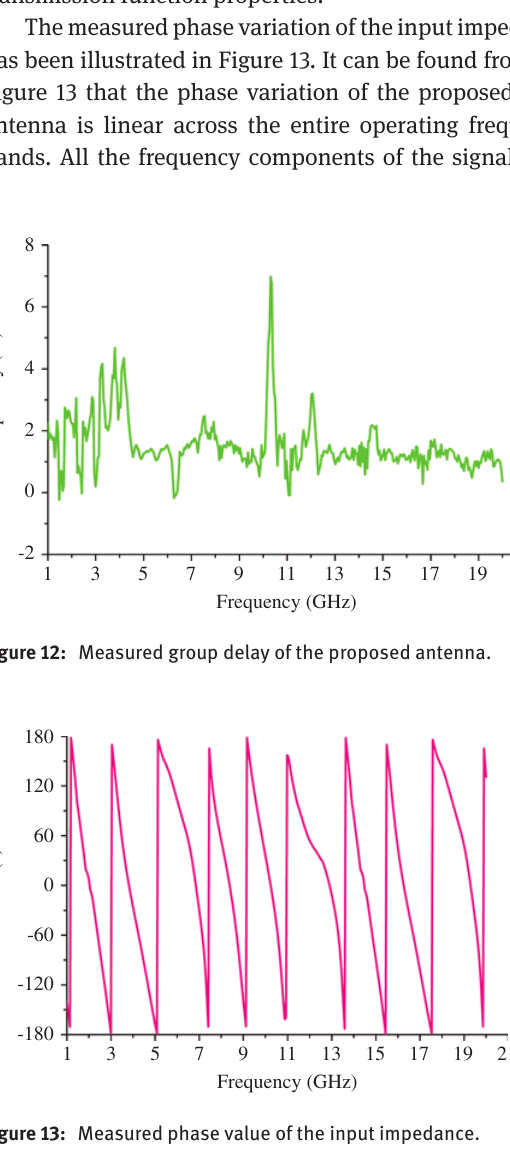
Figure 13: Measured phase value of the input impedance.